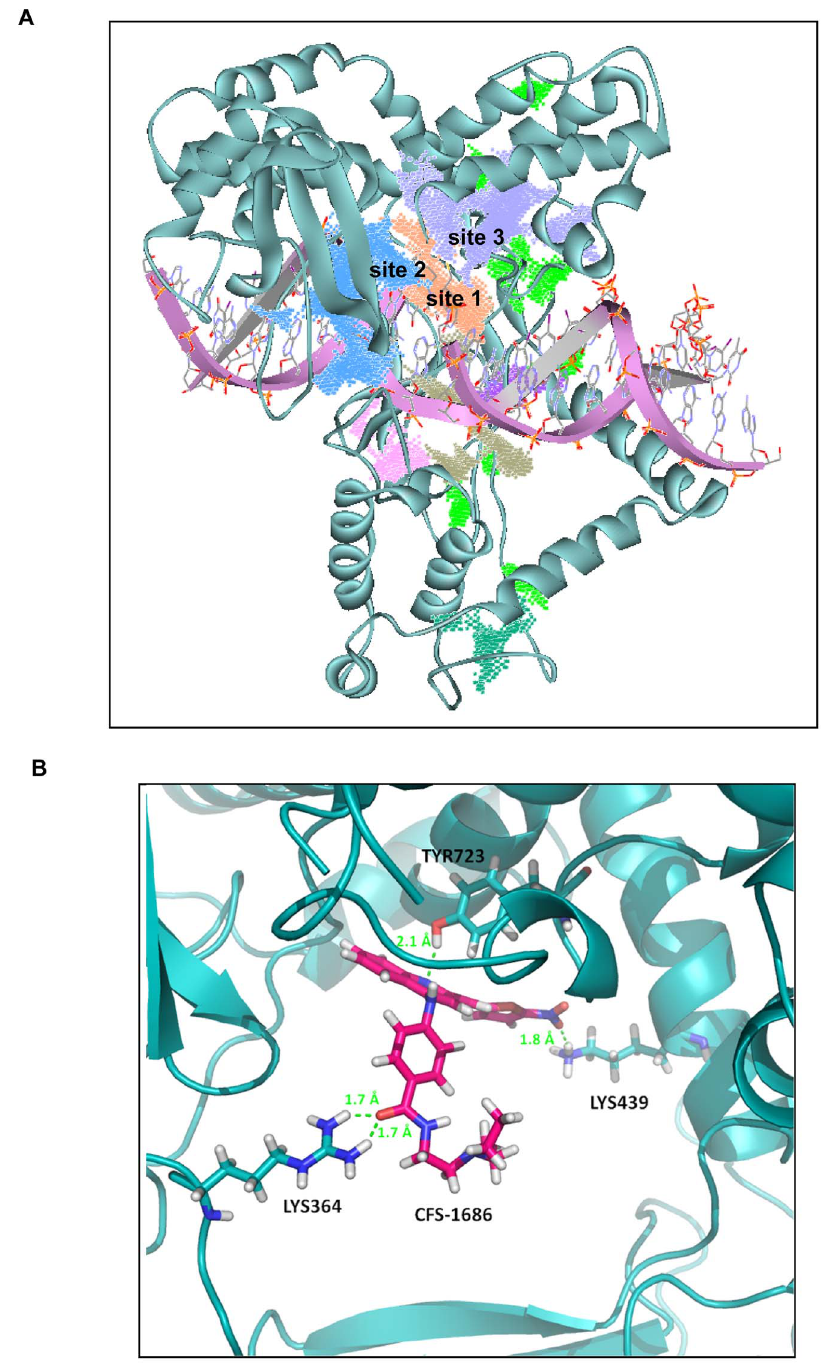
Figure 4. CFS-1686 could dock into the DNA binding site of Top1. (A) Three possible docking sites of CFS-1686, cited as 1, 2 and 3, were found in the interface of the top1-DNA complex. Site 1 was the best choice for docking simulation. (B) Detailed interaction of CFS-1686 at site 1. A LigandFit module was used to find the docking sites of CFS-1686 at the interface of the Top1-DNA complex.